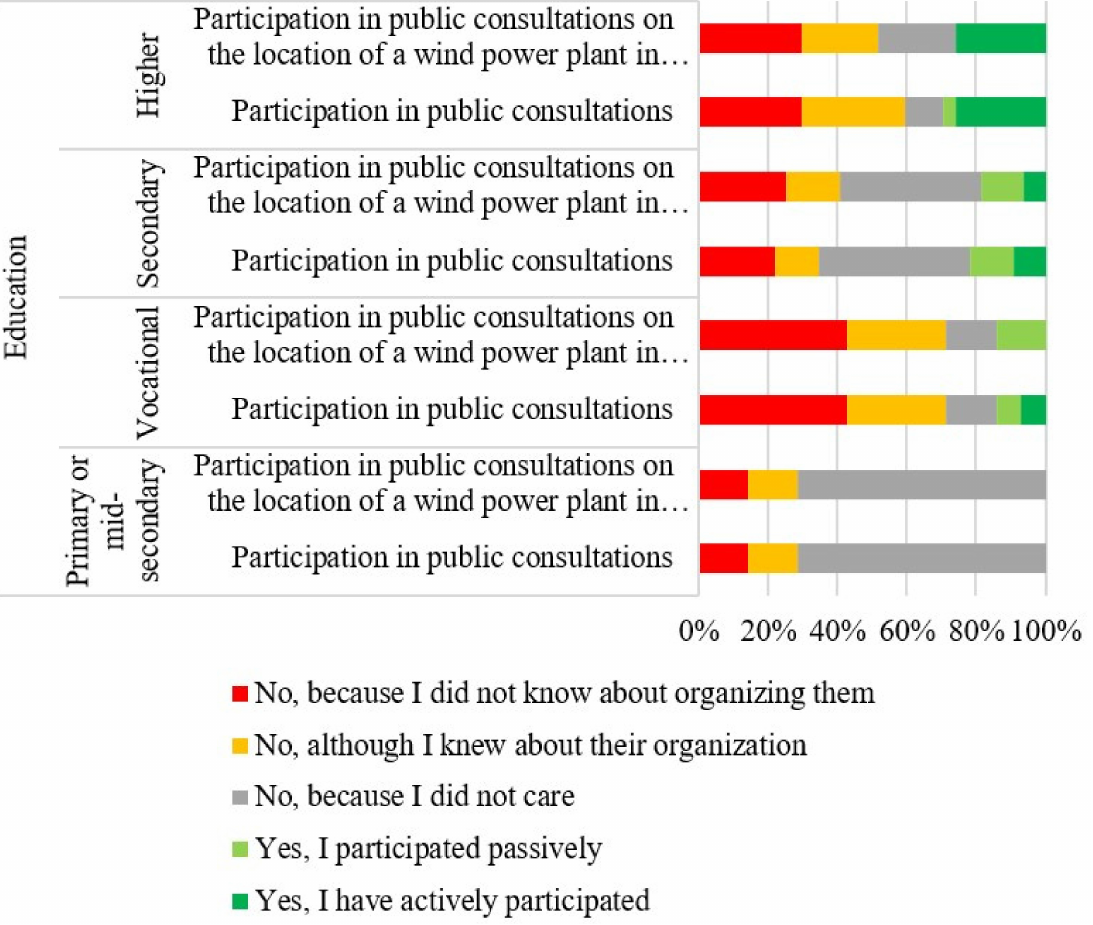
Figure 8. Participation in social consultations in general and in a case of the siting of a wind farm in the municipality of one’s residence depending on the education of respondents (%). Source: based on own